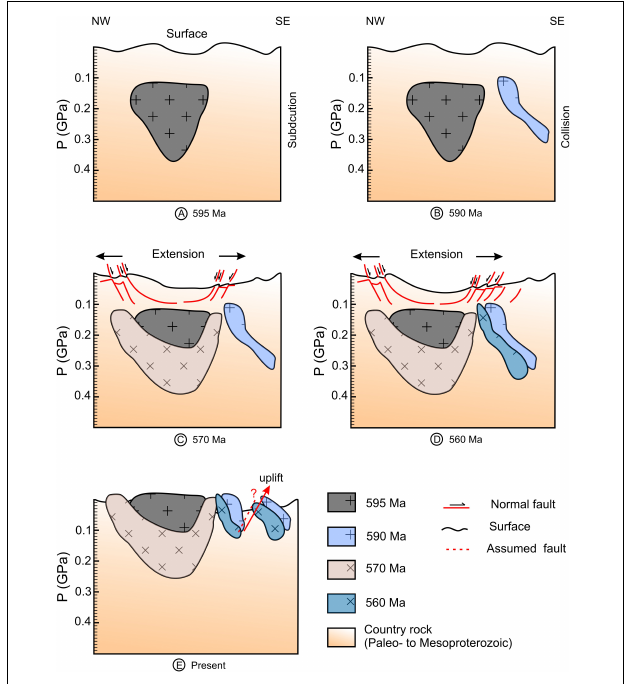
FIGURE 11 | A conceptual tectonomagmatic scenario for the crustal evolution of the Guéra Massif. (A) Emplacement of the ( ∼ 595 Ma) subduction-related collisional granites. (B) Emplacement of the ( ∼ 590 Ma) syn-collision granites. (C) Emplacement of the first generation ( ∼ 570 Ma) of post-collisional granites. (D) Emplacement of the second generation ( ∼ 560 Ma) of post-collisional granites. (E) Period of post-collisional uplift either immediately after emplacement ( ∼ 560 Ma) or possibly during faulting related to the Late Cretaceous West and Central African rift system